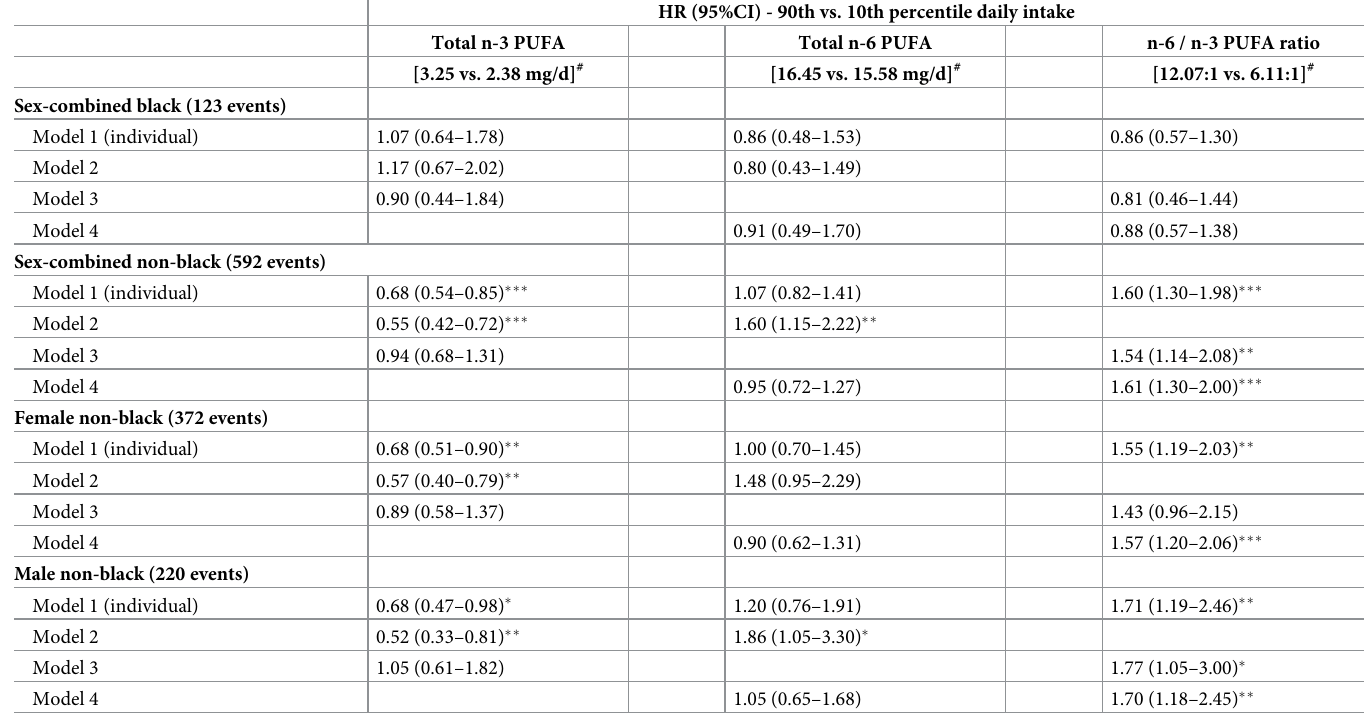
Table 3. Adjusted race- and sex-specific hazard ratios for total n-3 PUFA, total n-6 PUFA, and the n-6 / n-3 PUFA